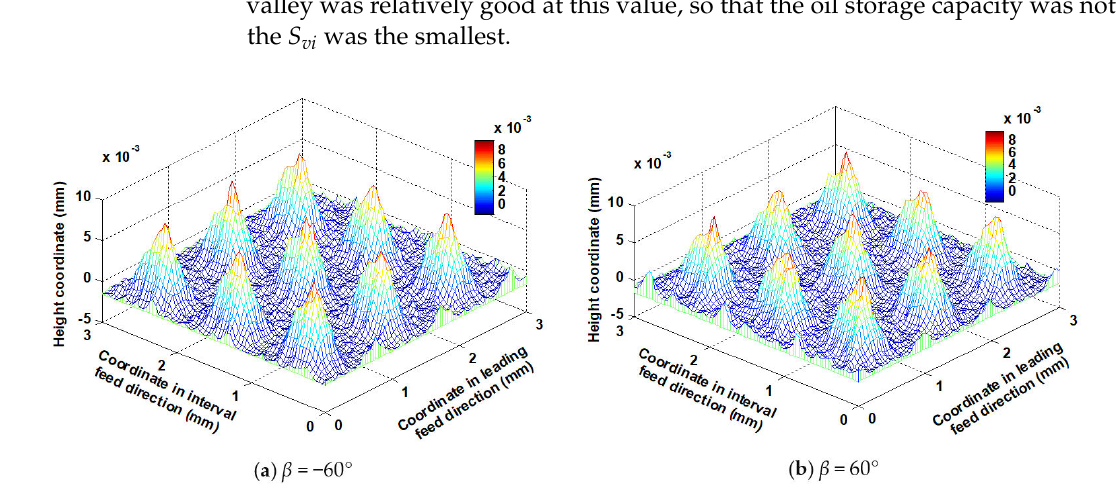
Figure 20. Ball-end trochoidal milling micro surface topography comparisons between different lead angles.